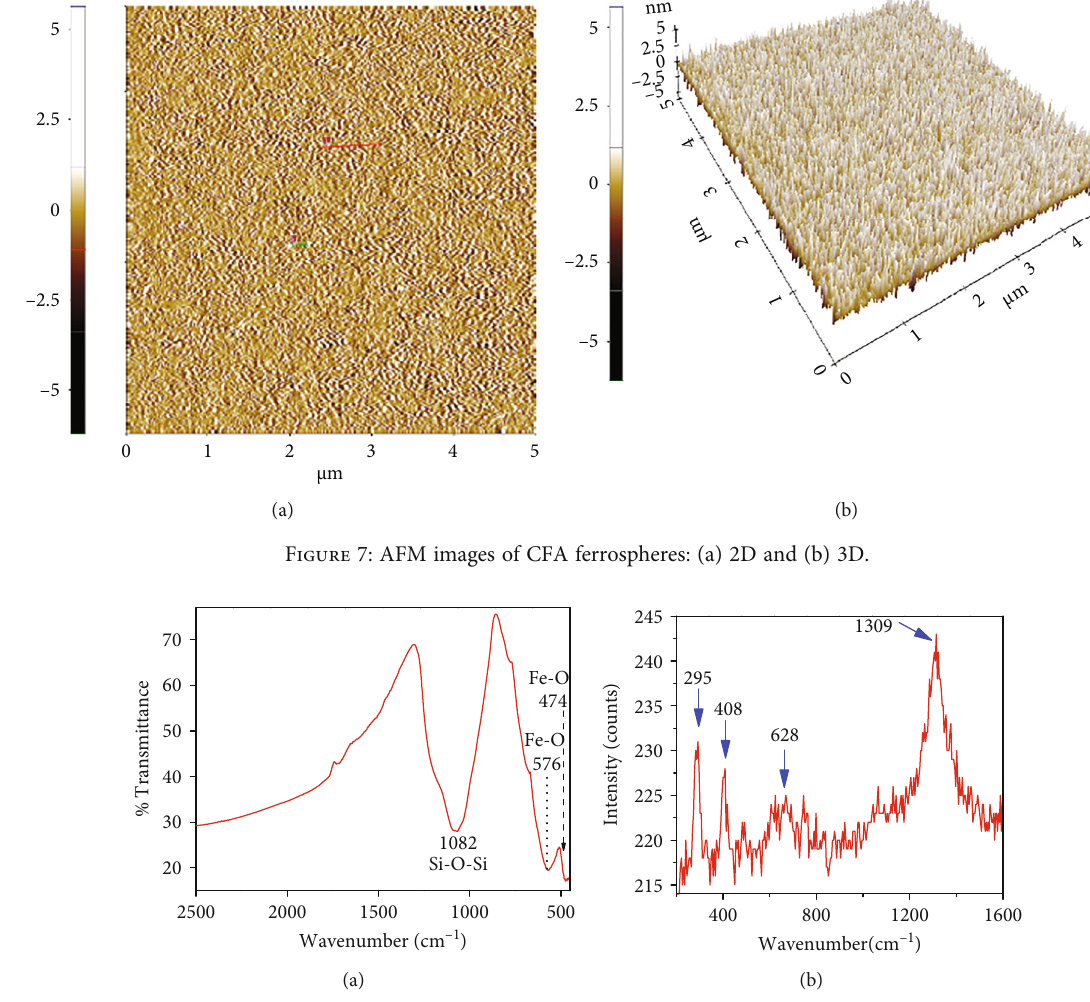
Figure 8: (a) FTIR spectra and (b) Raman spectra of CFA ferrospheres.